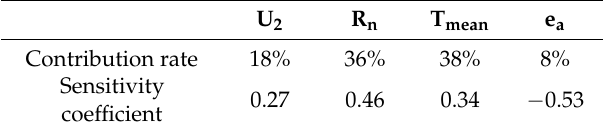
Table 6. Contribution rate and sensitivity coefficient of four meteorological factors to ET 0